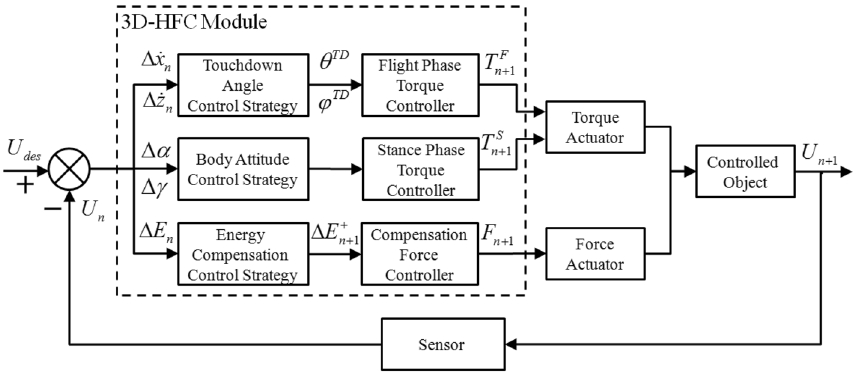
Figure 5. Schematic control system structure of the 3D-HFC method.